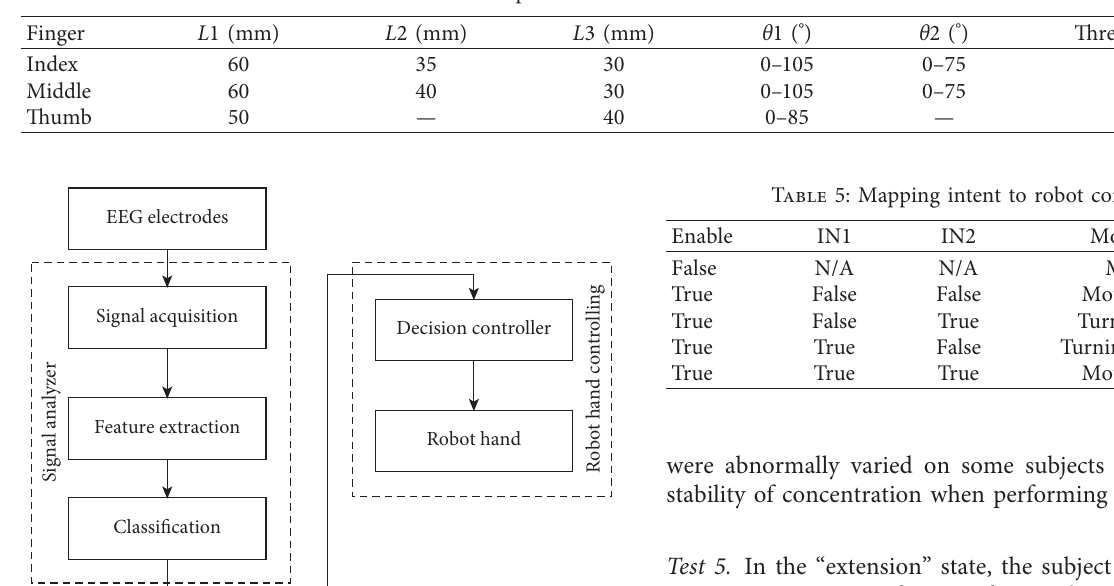
Figure 7: Physical view of the robot fingers and hand prototype. Table 4: Specifications of the robot hand model.